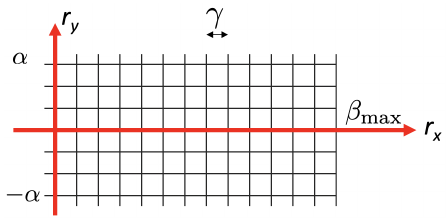
Figure 14. Search grid of rotation vectors.